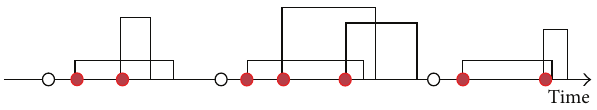
Figure 2: Schematic of the MBLRP model. White and gray circles represent the arrival time of storms and rain cells, respectively. Each rain cell is represented by a rectangle whose width and height represent rainfall duration and rainfall